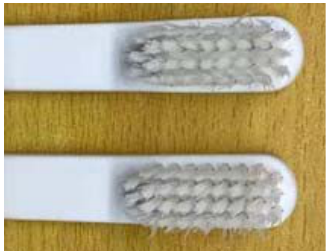
Figure 1. The shape of the finished product.